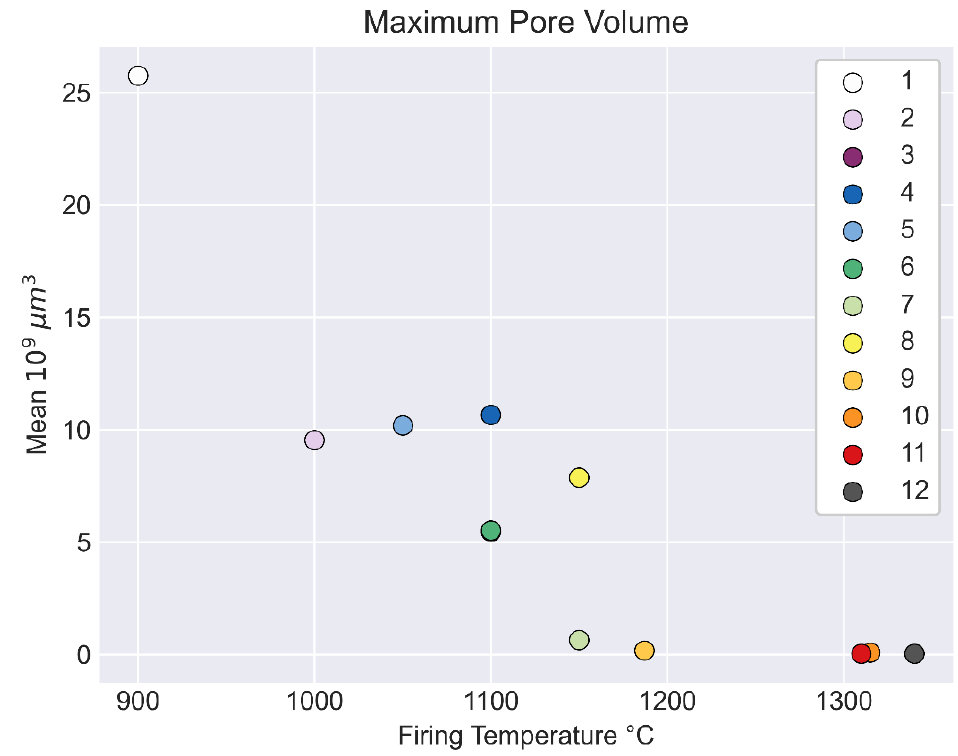
area of the pores) rises with increased firing temperatures. This is an indication of overall more spherical pores, since for a given volume, the ratio is maximized for spheres. Figure 8. Maximum pore volume goes down as firing temperature rises. Points are mean of 2. Other trends are related to pore morphological characteristics differing between lower and higher firing temperatures. One of these is seen in Figure 9, where the plot shows the pore volume-to-surface area ratio (volume in relation to the outside surface